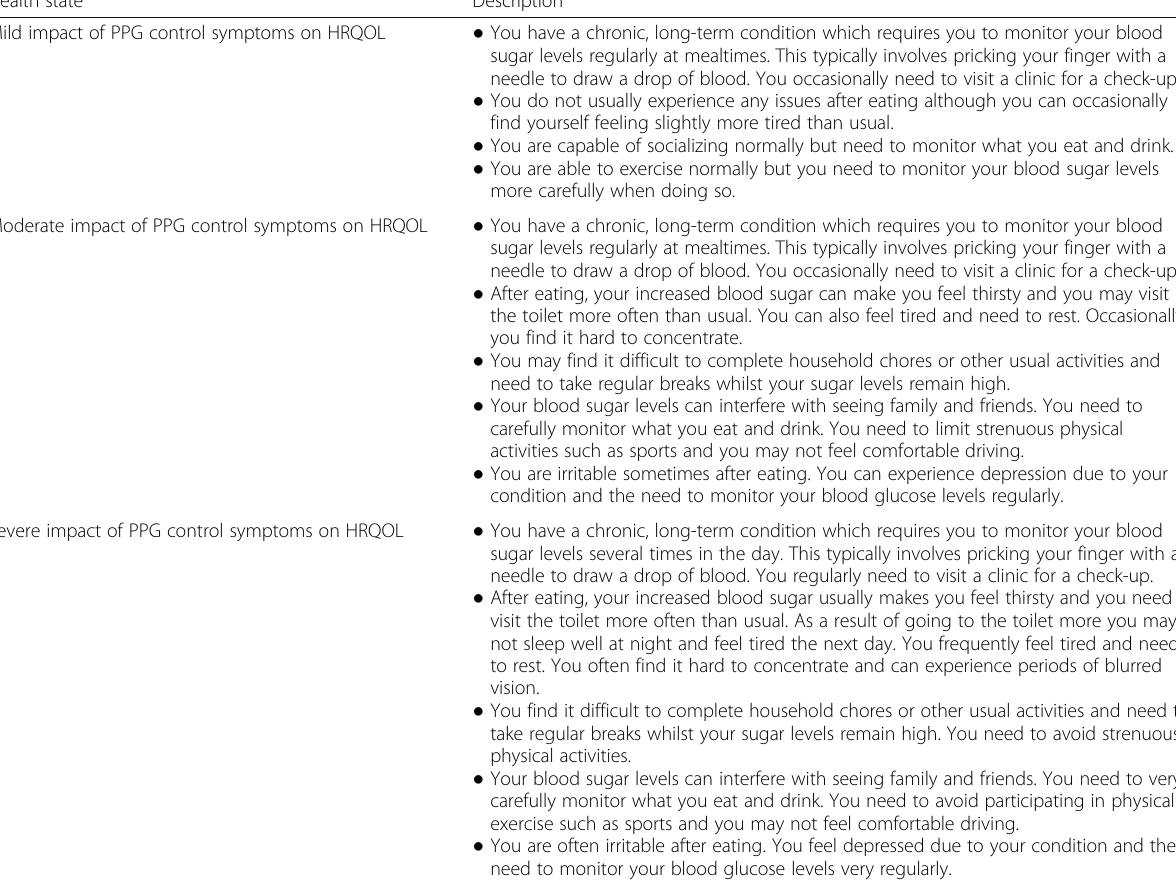
Table 1 Health state descriptions characterising mild, moderate and severe impact of postprandial glucose (PPG) control on health-related quality of life